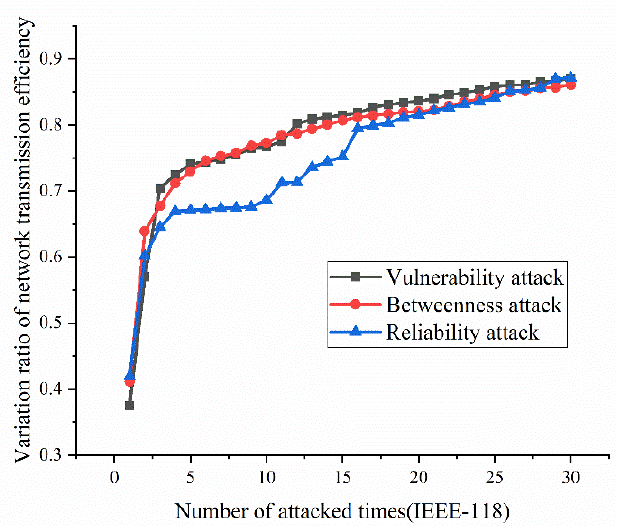
Figure 24. Variation ratio of network transmission efficiency of IEEE-118 bus system under extreme weather.